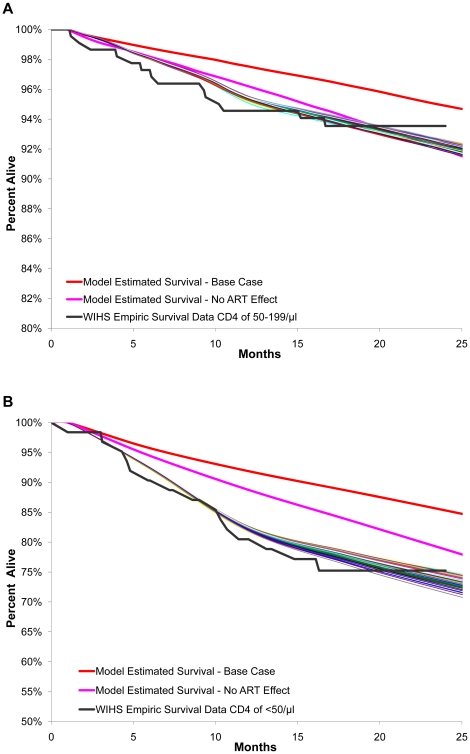
Top 50 best fits of WIHS empiric survival for CD4 50–199/µl and CD4 <50/µl.Part A of Figure 2 illustrates the top 50 best fits of the empiric survival data for CD4 50–199/µl. Nearly all runs in the top 50 combined changes in both ‘clinical effectiveness’ of HAART (a function of regimen efficacy, side effects or toxicity, adherence, and personal choice to remain on HAART) and estimates of CD4 gains while on effective HAART. The majority of the 50 best fits had a 2- to 3-fold increase in the rates of failure/switching/discontinuation of early lines of HAART in combination with an increase of 40%–75% in treatment efficacy in later lines of HAART. Part B of Figure 2 illustrates the top 50 best fits of the empiric survival data for CD4 <50/µl. Nearly all runs in the top 50 combined changes in both ‘clinical effectiveness’ of treatment (a function of regimen efficacy, side effects or toxicity, adherence, and personal choice to remain on HAART) and estimates of CD4 gains while on effective HAART. The majority of the 50 best fits had a 2- to 3-fold increase in the rates of failure/switching/discontinuation of early lines of HAART in combination with an increase of 30%–75% in treatment efficacy in later lines of HAART.